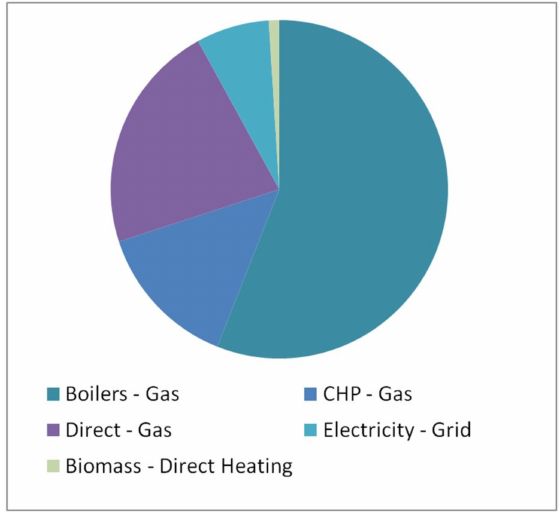
Figure 3. Energy consumption (2010–2015) ratio in the UK food manufacturing industry